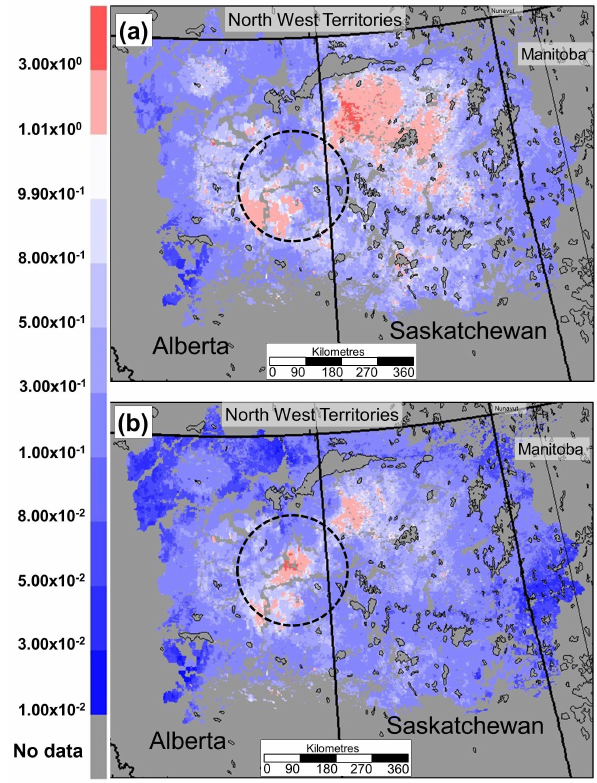
Figure 13. Ratio of estimates of base cation deposition to base cation fluxes exiting aquatic ecosystems. (a) Ratio of interpo- lated/extrapolated base cation flux from 1994 to 1998 observations to aquatic base cation flux. (b) Ratio of model-generated and precip- itation and aircraft-based corrected base cation flux to aquatic base cation flux. Circled region: 140km radius diameter circle around the Athabasca oil